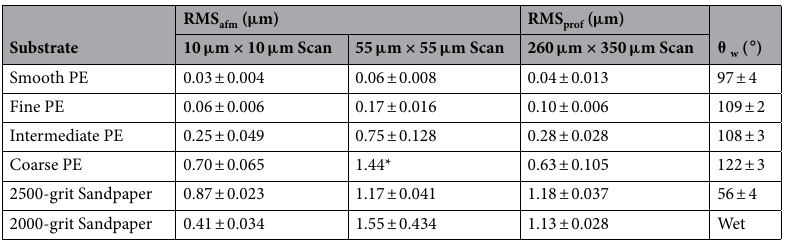
Table 1. Mean RMS height values characterized via atomic force microscopy (RMS afm ) and optical profilometry (RMS prof ), and water contact angle as a function of substrate. Values are reported as mean ± 1 s.e.m. The 2000-grit sandpaper was immediately wetted by water, thus the water contact angle for this substrate is listed as wet. *Only one scan was able to be completed on this substrate. PE =